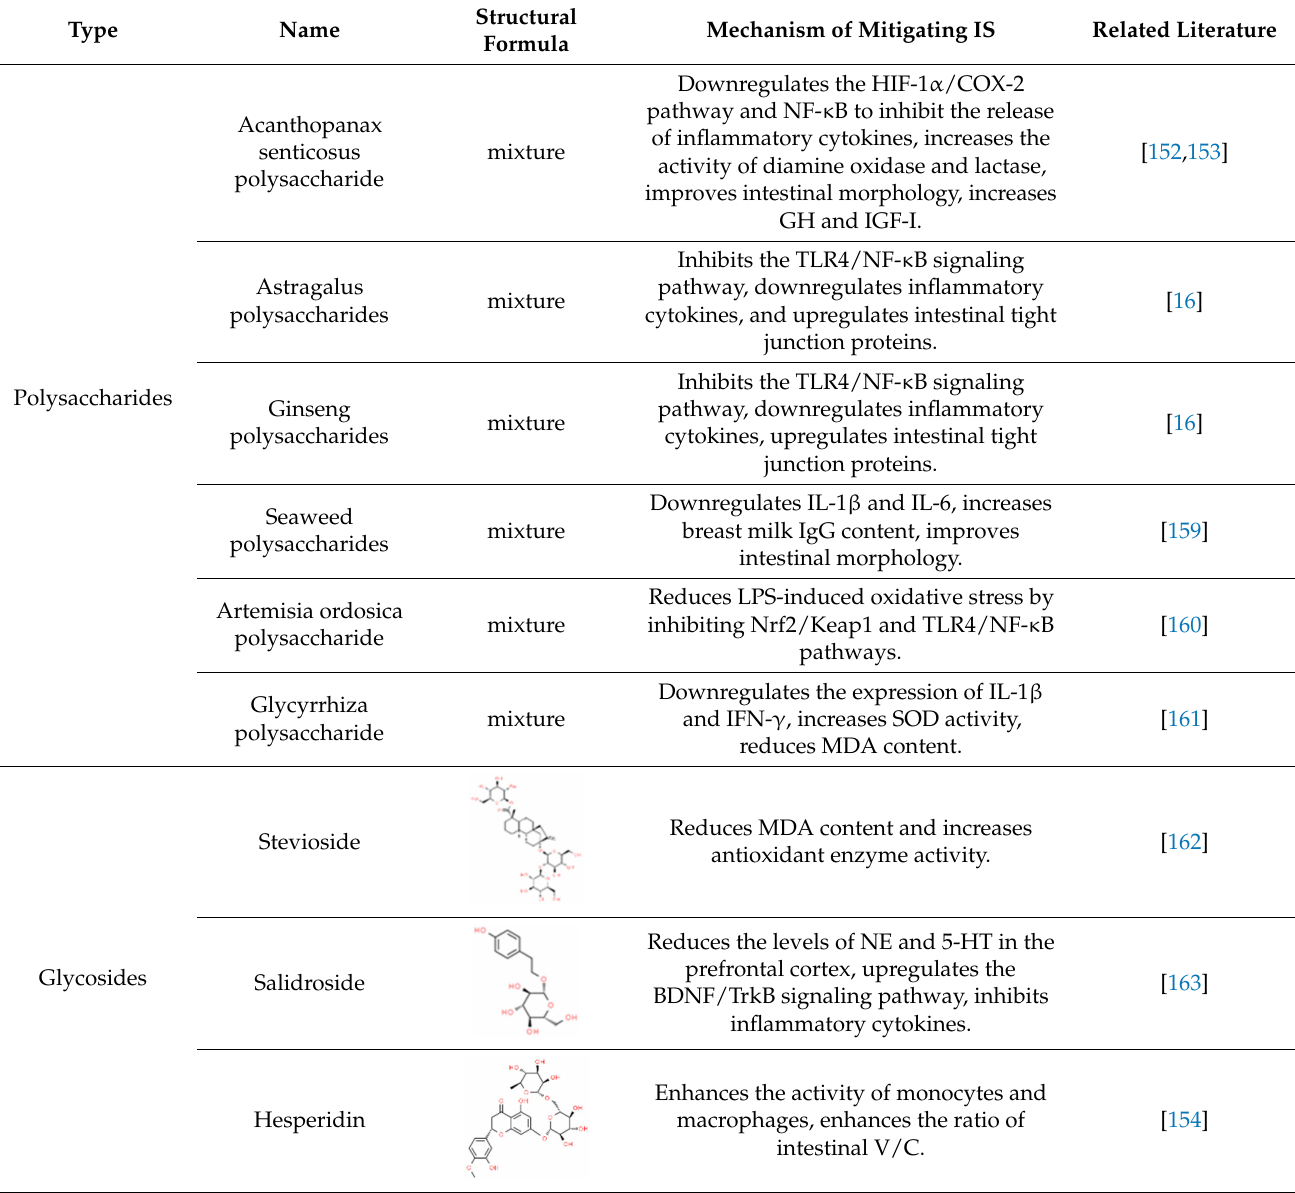
Table 1. A select list of plant extracts that alleviate